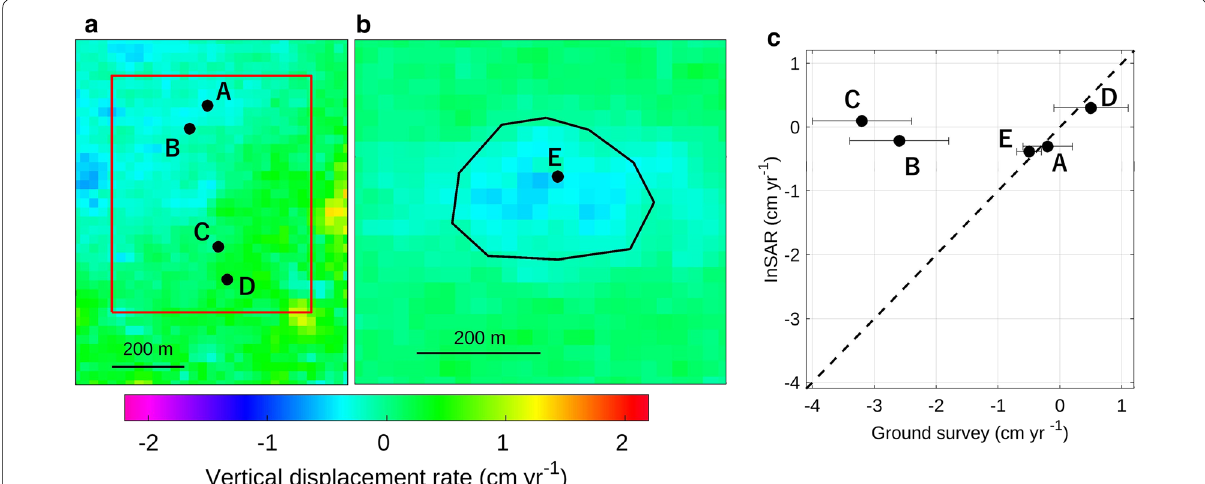
Fig. 7 Comparison of surface displacement data obtained by field survey and InSAR. Enlarged views of SM3 single interferograms for a September 29, 2017, and September 28, 2018 (as in Fig. 3b) in the ground survey area at Plots A–D, and b October 2, 2015 and September 28, 2018 at Plot E. c Comparison of the field survey and the InSAR displacement. The number of leveling measurements for Plots A–E are 33, 38, 36, 31, and 7,